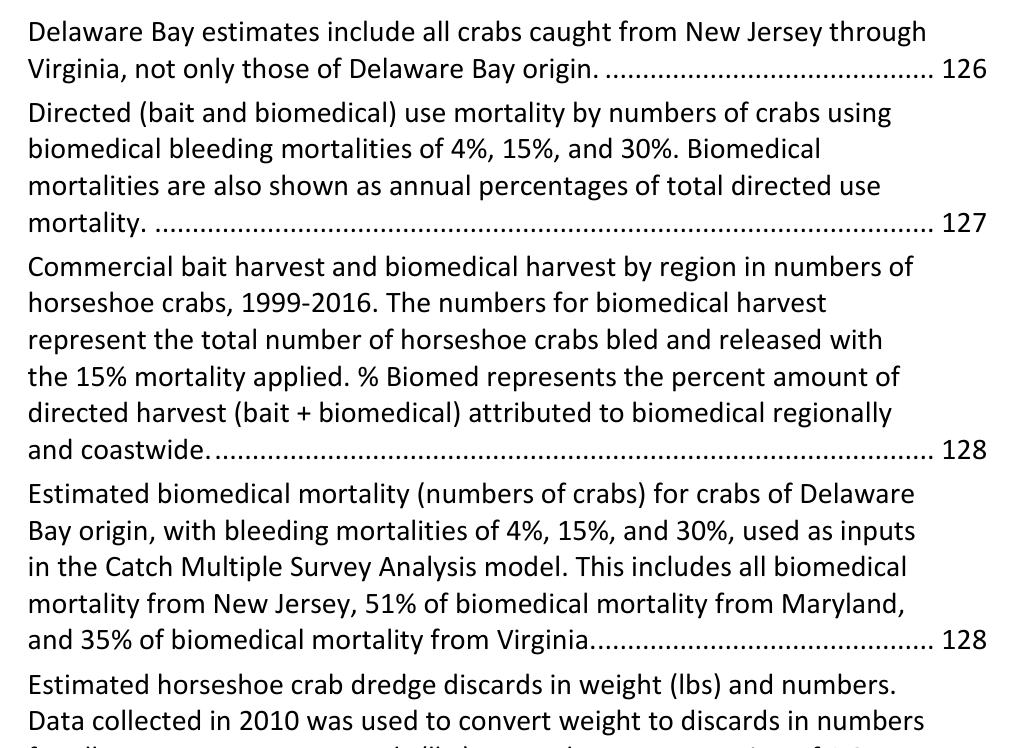
Delaware Bay estimates include all crabs caught from New Jersey through Table 27. Directed (bait and biomedical) use mortality by numbers of crabs using biomedical bleeding mortalities of 4%, 15%, and 30%. Biomedical mortalities are also shown as annual percentages of total directed use Table 28. Commercial bait harvest and biomedical harvest by region in numbers of horseshoe crabs, 1999-2016. The numbers for biomedical harvest represent the total number of horseshoe crabs bled and released with the 15% mortality applied. % Biomed represents the percent amount of directed harvest (bait + biomedical) attributed to biomedical regionally Table 29. Estimated biomedical mortality (numbers of crabs) for crabs of Delaware Bay origin, with bleeding mortalities of 4%, 15%, and 30%, used as inputs in the Catch Multiple Survey Analysis model. This includes all biomedical mortality from New Jersey, 51% of biomedical mortality from Maryland, Table 30. Estimated horseshoe crab dredge discards in weight (lbs) and numbers. Data collected in 2010 was used to convert weight to discards in numbers for all years. To convert pounds (lbs) to numbers, a conversion of 1.8 Table 31. Estimated horseshoe crab gill net discards in weight (lbs) and numbers. Data collected in 2005 was used to convert weight to discards in numbers for all years. To convert pounds (lbs) to numbers, a conversion of 1.8 Table 32. Estimated horseshoe crab trawl discards in weight (lbs) and numbers. Year-specific data was used to convert weight to numbers for 2012-2016. For the remaining years, data was pooled among all years of available Table 33. Surveys considered for developing abundance indices for horseshoe crab. Table indicates which surveys were accepted for index development and Table 34. List of fishery-independent surveys that were developed in relative abundance indices for this stock assessment, the gear used in the survey, the minimum and maximum prosomal width, and median prosomal Table 35. Indices of bay-wide male and female horseshoe crab spawning activity (ISA), number of beaches surveyed, standard deviation (SD), coefficient of variations (CV), 90% confidence intervals (CI) and sex ratio for the Table 36. Results of the power analysis by survey for linear and exponential trends in horseshoe crab abundance indices over a twenty-year period. 2019 Horseshoe Crab Benchmark Stock Assessment Non-Confidential Report